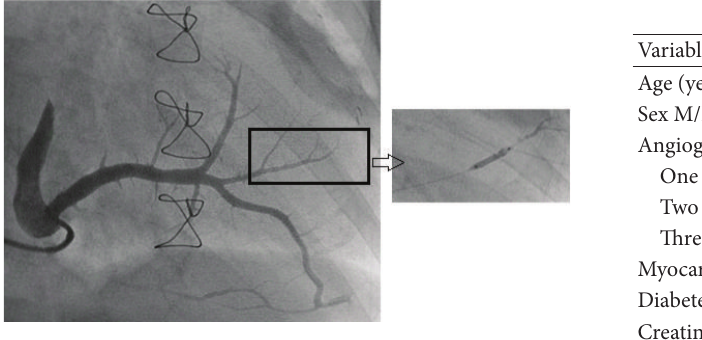
Figure 1: Retrograde delivery. Coronary sinus is cannulated using AL-1 catheter. Venogram shows anterolateral vein branches asso- ciated with infarcted area. The vein branch which is end vessel is selected as target vein. End vessel is confirmed by contrast injection through inflation over the wire balloon which shows no collateral (inset). Stem cells were delivered via the same balloon which is kept inflated for 15 minutes afterward.